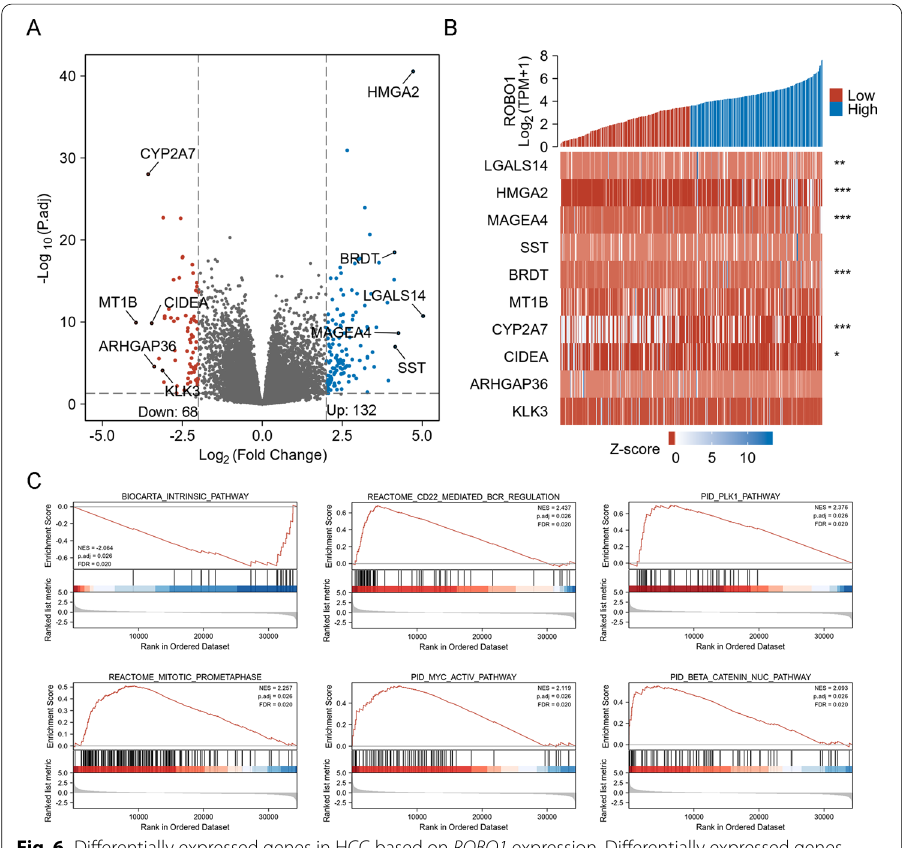
Fig. 6 Differentially expressed genes in HCC based on ROBO1 expression. Differentially expressed genes were categorized on the basis of ROBO1 high- and low-expression subgroups ( A ). Heatmap presents the expression of the top five up-regulated and down-regulated genes in HCC tissues ( B ). GSEA analysis based on ROBO1 -related differentially expressed genes in HCC ( C